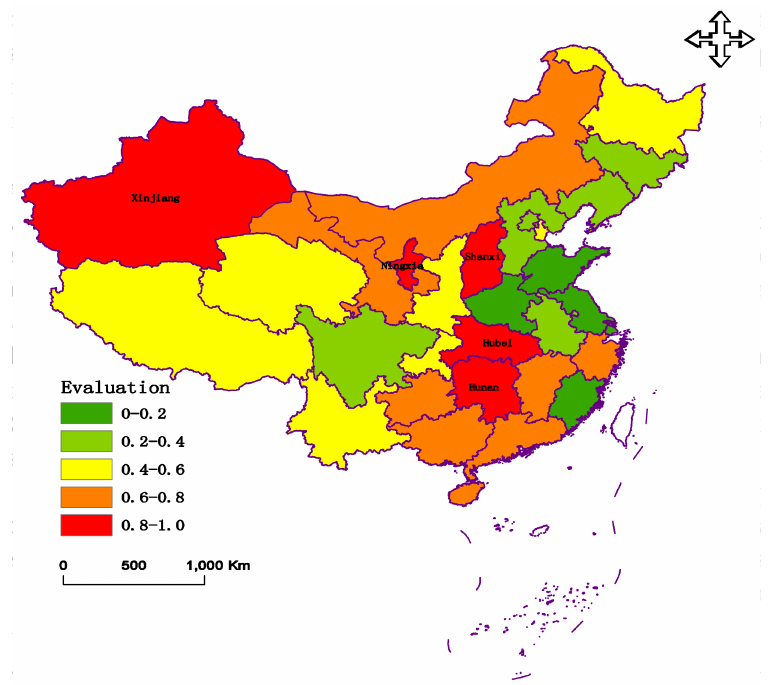
Figure 6. The CC j values from the